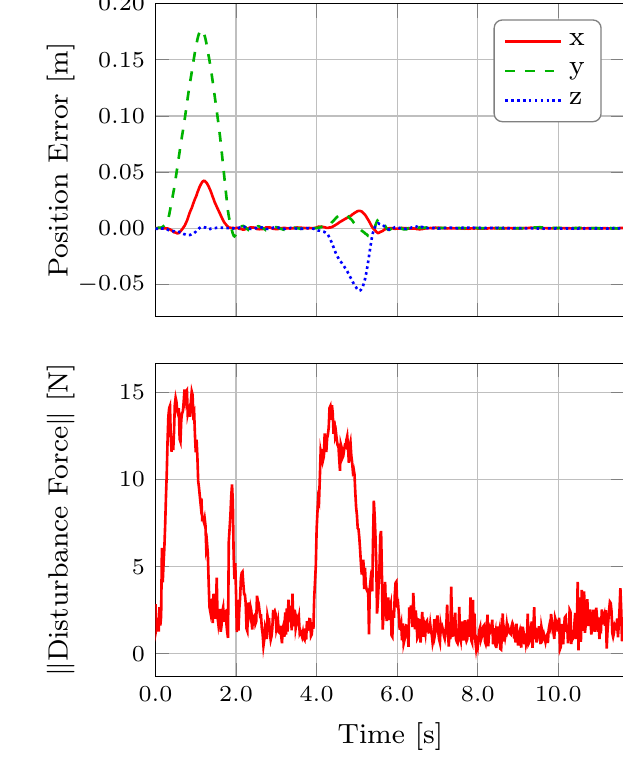
Fig. 17 Cartesian position error and applied disturbance force dur- ing the tracking experiment without payload